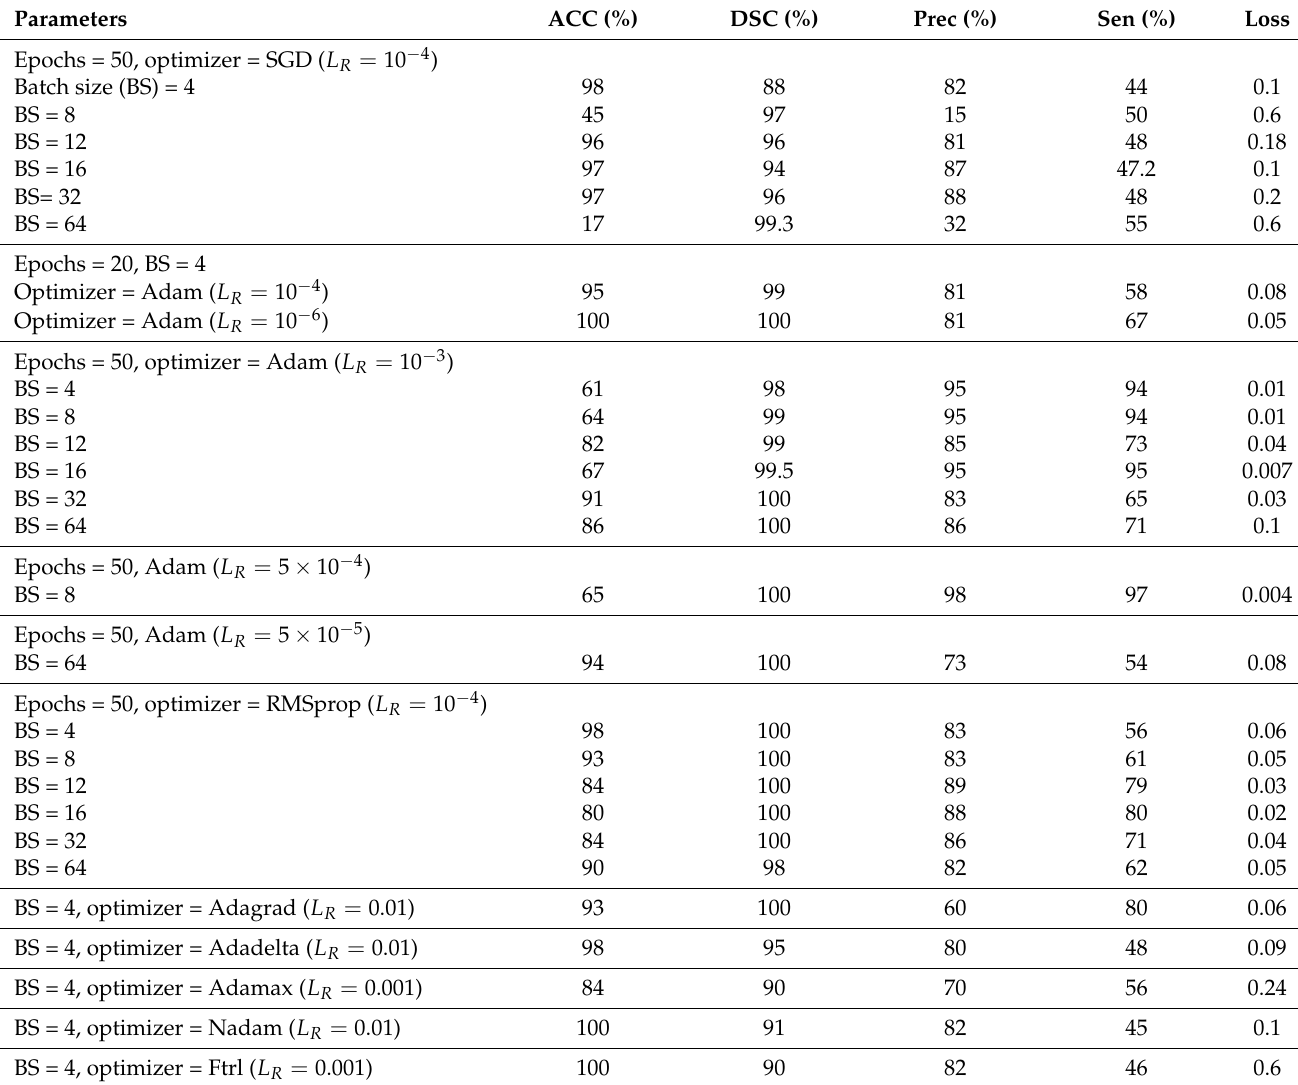
Table 7. The hyper-parameters of the proposed ML-CNN model to diagnose various